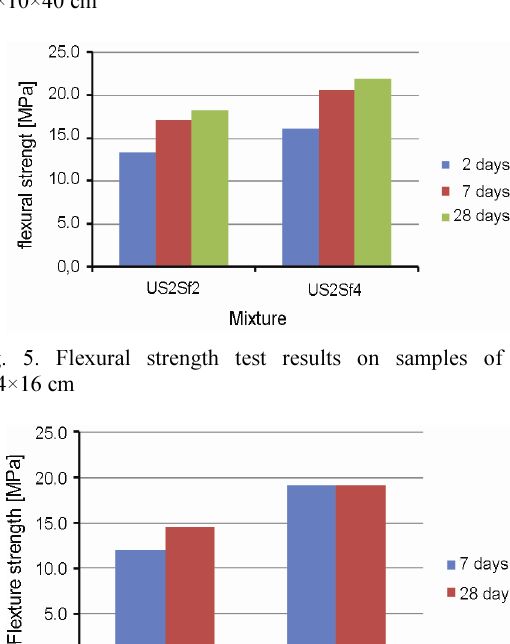
Fig. 4. Compressive strength test results on samples of